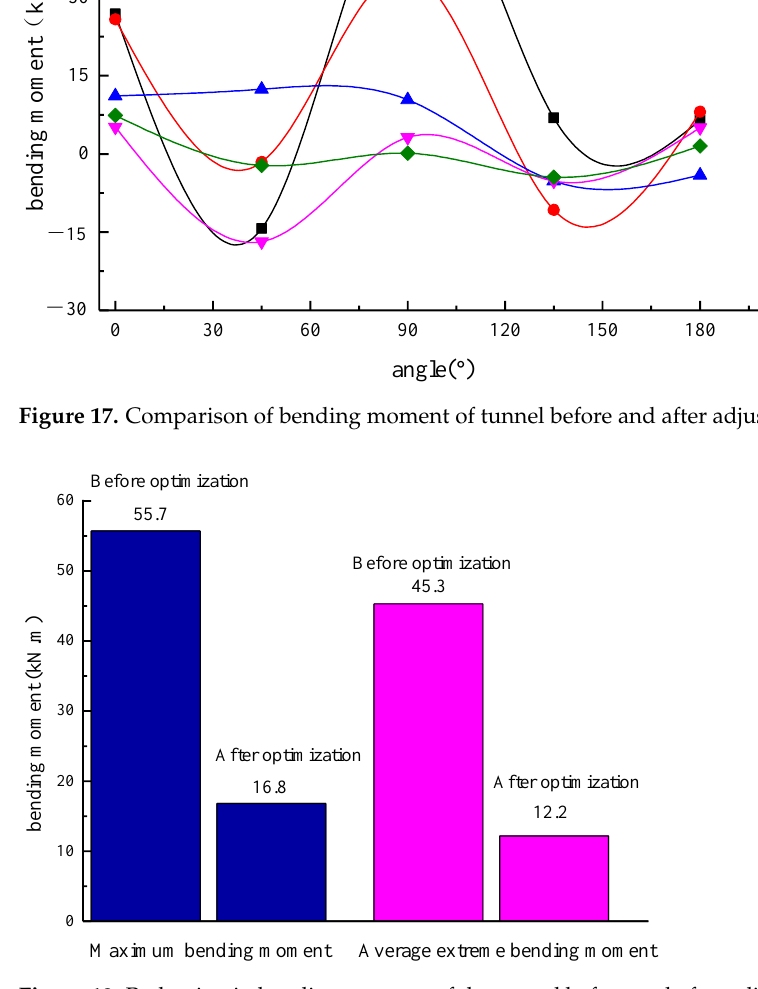
Figure 18. Reduction in bending moment of the tunnel before and after adjustment.